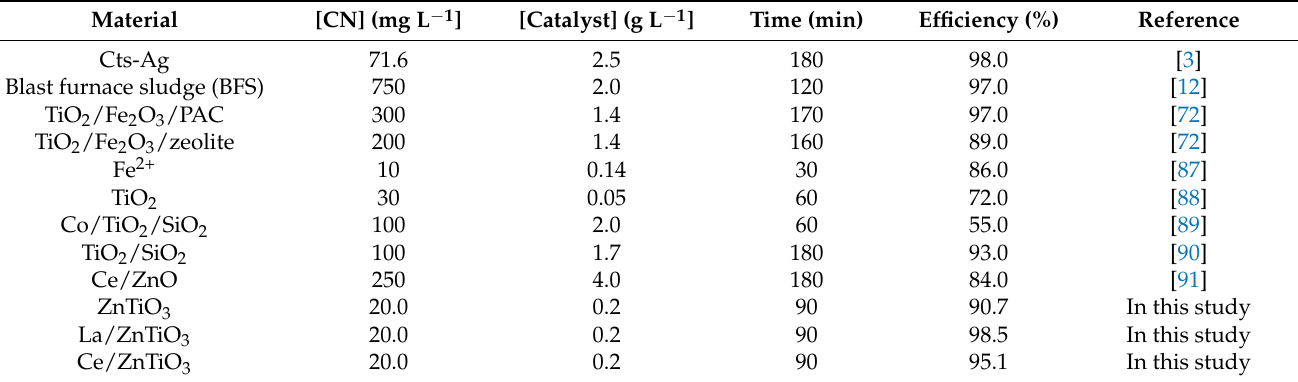
Figure 11. Percentage of ( a ) individual and ( b ) accumulated cyanide adsorbed and photodegraded by the nanoparticles. Table 5. Comparison of the photodegradation efficiency (%) of various materials for cyanide